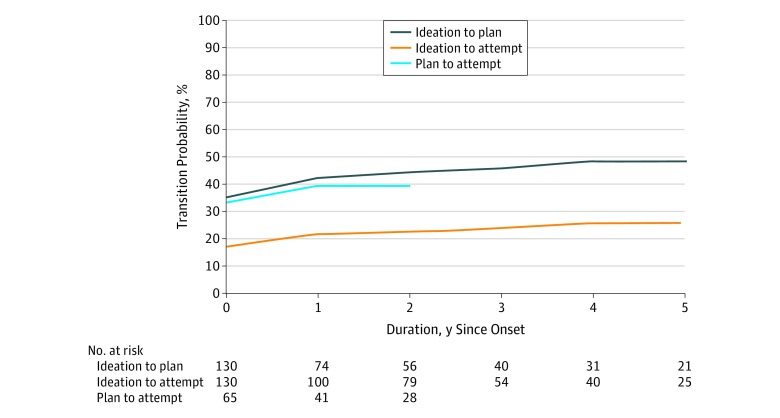
Risk and Speed of Transition From Suicidal Ideation to Plan, Ideation to Attempt, and Plan to AttemptTransition probabilities for suicidal ideation are shown by years since onset of suicidal ideation. The observed ranges were 0 to 7 years from ideation to plan, 0 to 4 years from ideation to attempt, and 0 to 1 year from plan to attempt. Of note, all male participants reported that the first plan and attempt appeared in the same year (3 participants). In the graph, only years with at least 20 individuals at risk are reported. Reported numbers at risk under the graph are based on the unweighted Kaplan-Meier estimation. For the transition from ideation to plan, the probabilities were 35.1% at year 0 (same year) and 48.2% at year 5 (male participants, year 0, 21.8% and year 3, 28.4%; female participants, year 0, 44.8% and year 5, 62.7%; early onset, age <14 years, year 0, 24.9% and year 5, 33.4%; late onset, age >13 years, year 0, 39.0% and year 5, 55.0%). For the transition from ideation to attempt, the probabilities were 17.0% at year 0 and 25.8% at year 5 (male participants, year 0, 10.8% and year 4, 16.1%; female participants, year 0, 21.4% and year 5, 32.7%; early onset, age <14 years, year 0, 16.1% and year 4, 27.5%; late onset, age >13 years, year 0, 17.3% and year 5, 25.4%). For the transition from plan to attempt, the probabilities were 33.2% at year 0 and 39.2% at year 3 (male participants, year 0, 25.6%; female participants, year 0, 35.8% and year 2, 43.5%; early onset, age <15 years, year 0, 34.5% and year 2, 38.5%; late onset, age >14 years, year 0, 32.6% and year 2, 39.5%).